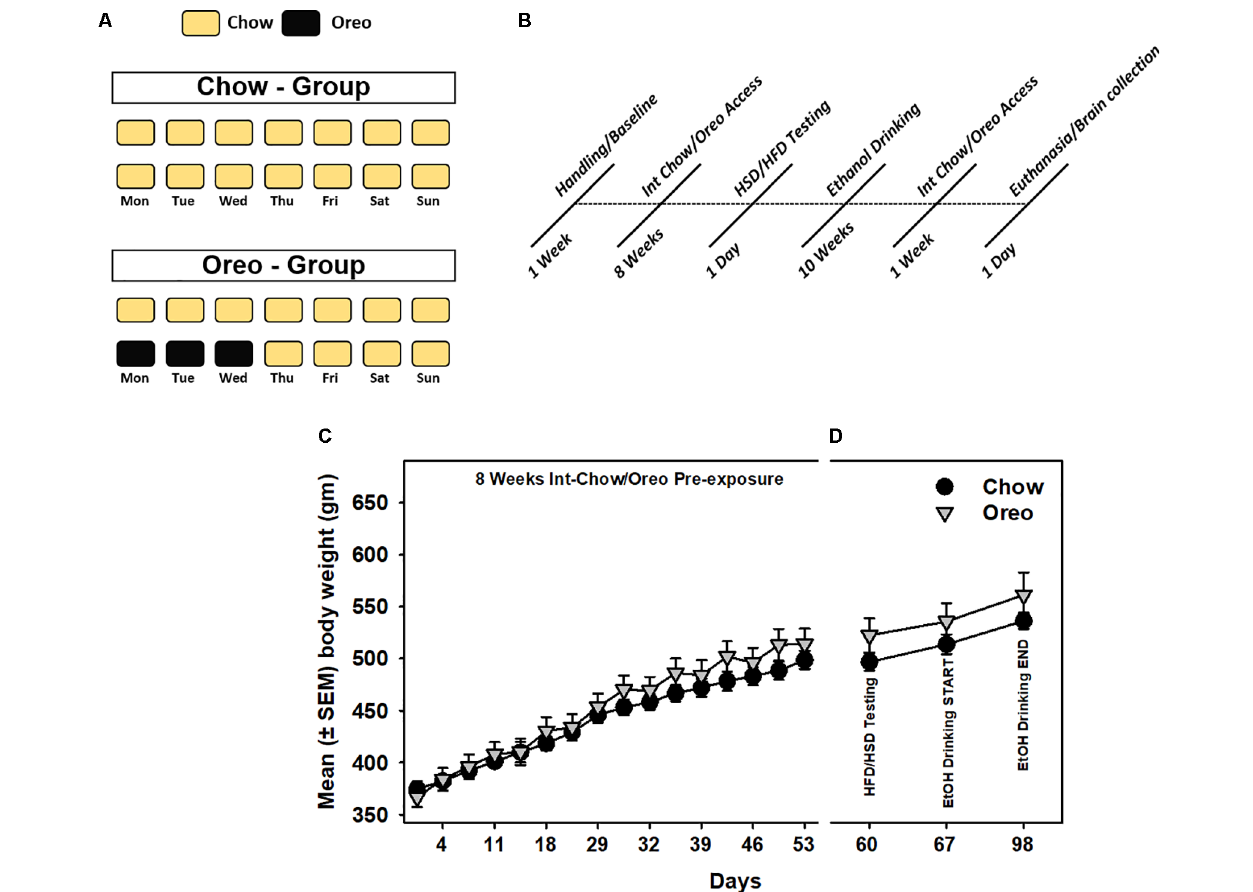
FIGURE 1 | Schematic representation of patterned feeding paradigm and associated body-weight changes. (A) During the feeding paradigm, experimental group of rats ( n = 5/group) received 24 h intermittent access (Mon, Tue, and Wed) to Double Stuff Oreo cookies whereas control group of rats received chow. (B) A timeline showing a series of behavioral and biochemical testing following initial 8 weeks of patterned feeding. All rats had ad libitum access to chow and water. Mean ( ± SEM) body weight readings during (C) initial 8 weeks of pre-exposure and (D) subsequent testing sessions. There was no significant difference between body weights of the control and the experimental group at any time